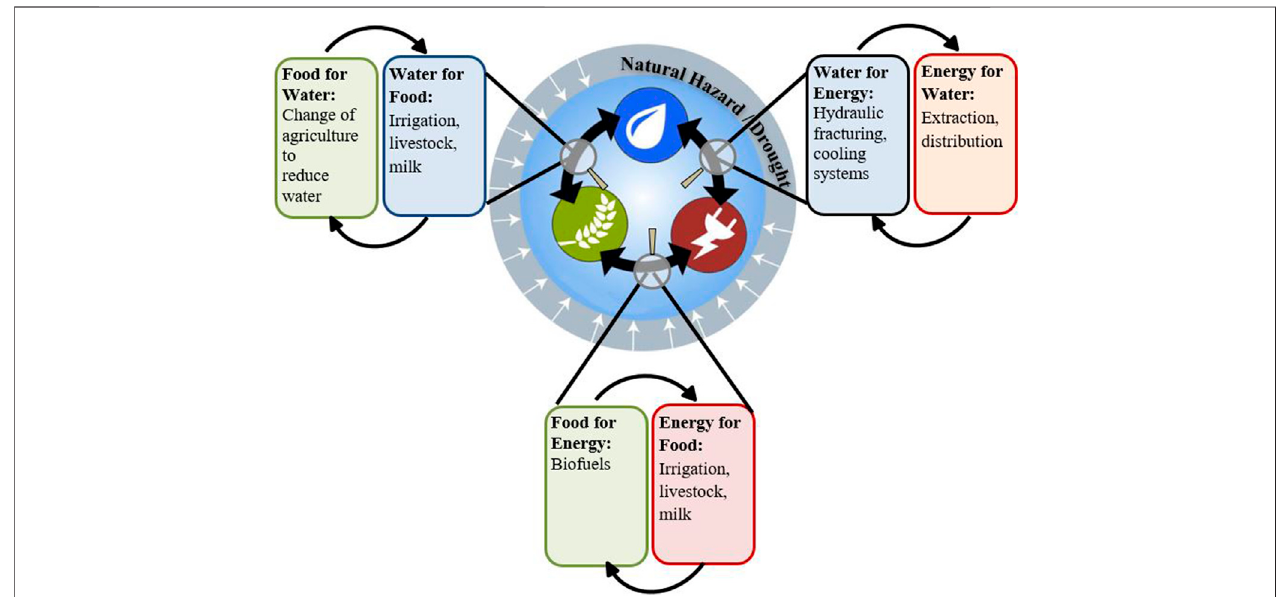
FIGURE 3 | New Mexico food – energy – water (FEW) nexus describing the relationships and interconnections of its components under climate and socioeconomic drivers.